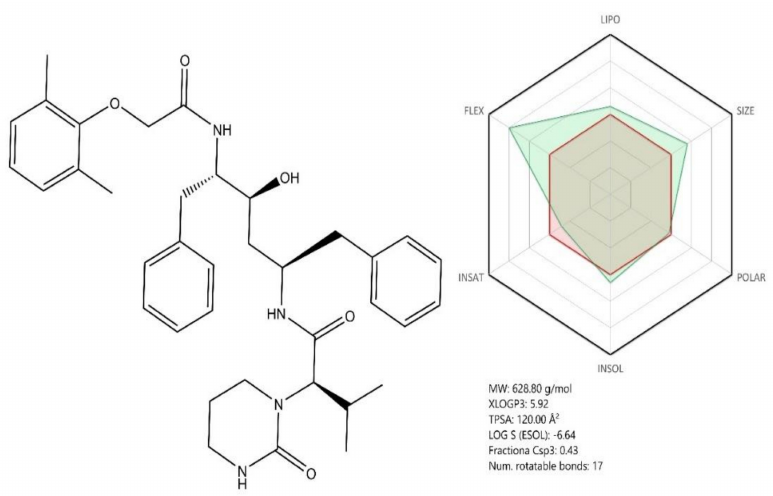
Figure 8. Chemical structure of Lopinavir; ADME profile was achieved using the free web tool SwissADME; the red highlighted area represents the suitable physicochemical space for oral bioavailability covering value intervals for the following: LIPO (lipophility): − 0.7 < XLOGP3 < + 5.0, SIZE: 150 g / mol < MV < 500 g / mol, POLAR (polarity): 20Å 2 < TPSA < 130Å 2 , INSOLU (insolubility): 0 < Log S (ESOL) < 6, INSATU (insaturation): 0.25 < Fraction Csp3 < 1, FLEX (flexibility): 0 < Num. rotatable bonds < 9, whereas the overlapped green highlighted area shows the calculated ADME profile for the molecule [63].